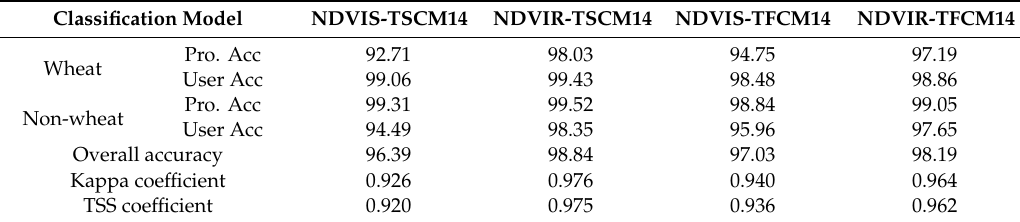
Table 5. Confusion matrix for the classification results using NDVI-TSCM14 and NDVI-TFCM14 under the support vector machine (SVM) and random forest (RF) classifiers (%).